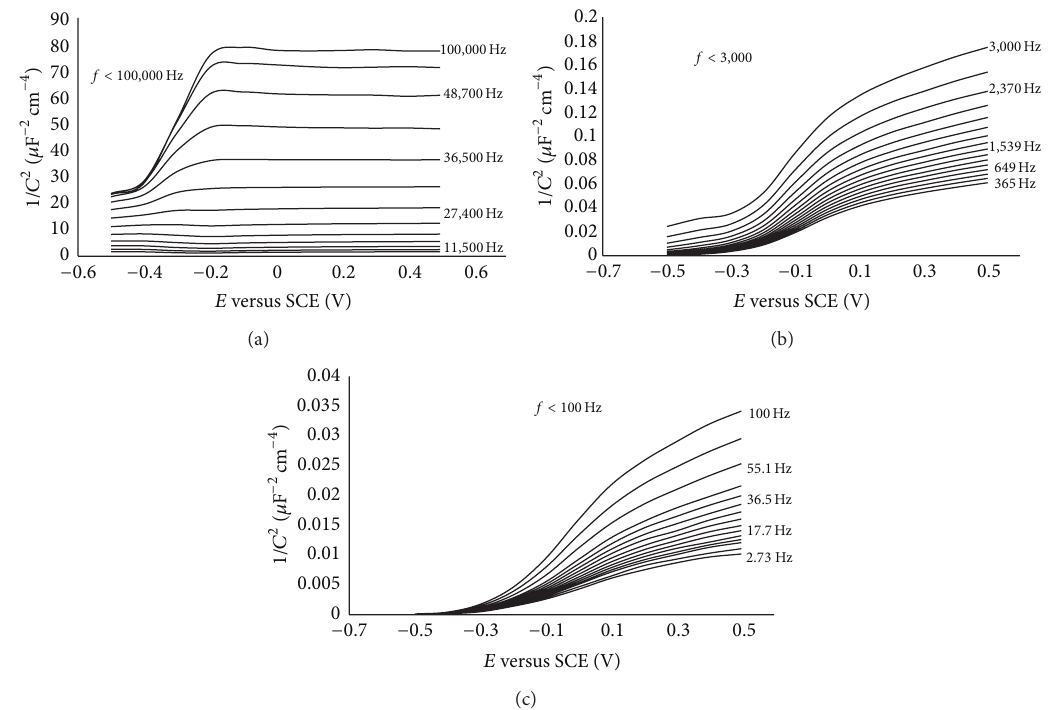
Figure 7: Mott Schottky plots of NT sample in different ranges of